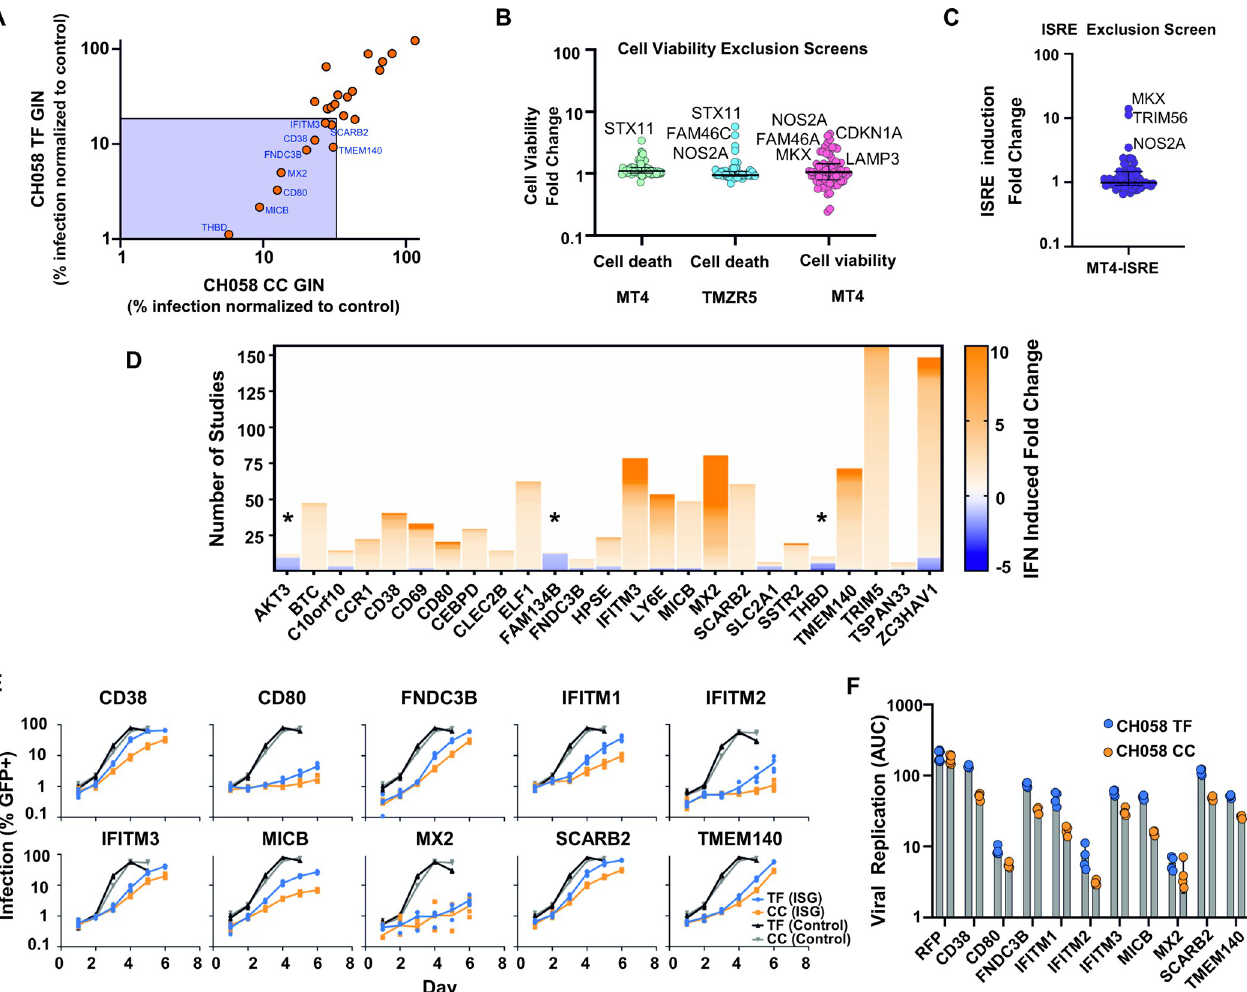
Fig 3. Anti-HIV-1 ISGs inhibit the CC virus more potently than transmitted HIV-1. (A) Candidate anti-HIV-1 effectors that were more inhibitory than the known anti-HIV-1 effector IFITM3 were tested against CH058 GIN GFP-IRES-Nef) TF and CC viruses on MT4-R5 cells, as in 2F-G, normalised to the level of infection observed in the presence of an empty vector control. (B-C) ISGs in Fig 3A were tested for ability to induce cell death or ISRE (IFN-stimulated response element). In B, MT4 and TMZR5 cells were tested for cell death when expressing ISGs by flow cytometry using the LIVE/DEAD fixable dead cell stain kit (Invitrogen) and MT4 cell viability was additionally tested using the luminescence based CytoTox-Glo Cytotoxicity assay (Promega). In C, IFN induction by candidate ISGs was measured by flow cytometry using MT4 cells expressing an ISRE-GFP construct. (D) Candidate ISGs from Fig 3A were checked for their changes in expression upon type I IFN stimulation using the Interferome database to determine their ‘ISG-ness’. (E-F) Validation of the 8 most potent anti- HIV-1 effector ISGs, along with IFITM1 and IFITM2 controls, against CH058 TF and CC viruses, In E, TMZR5 cells transduced with pLV constructs containing the indicated ISGs or RFP as a control, were challenged with CH058 TF or CC and sampled daily to monitor virus spread. GFP-positive cells were enumerated using flow cytometry. Viral spreading replication experiments took place on two occasions, a typical result with contemporaneous controls is shown. In F, data from panel E represented as area under the curve